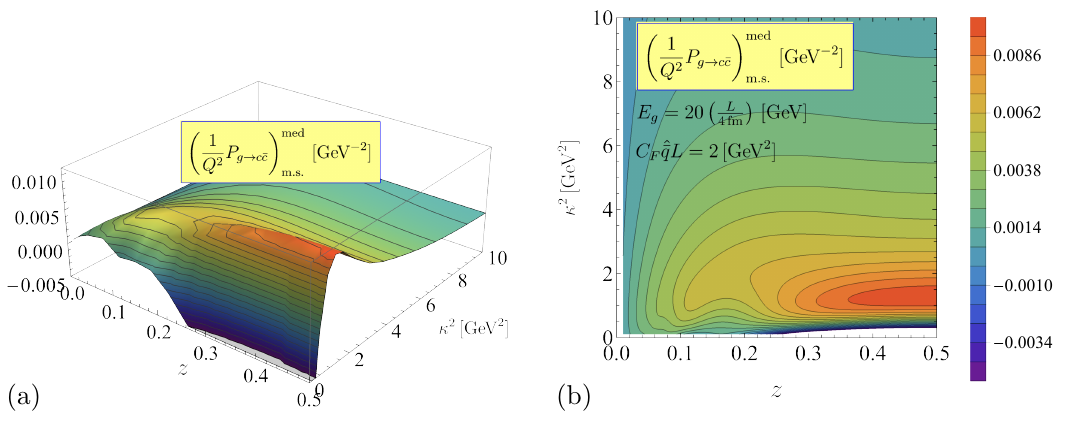
Figure 6 . The medium-modified g → c ¯ c splitting function evaluated in the saddle point approxi- mation (4.10)–(4.13). The two panels show different representations of the same calculation.